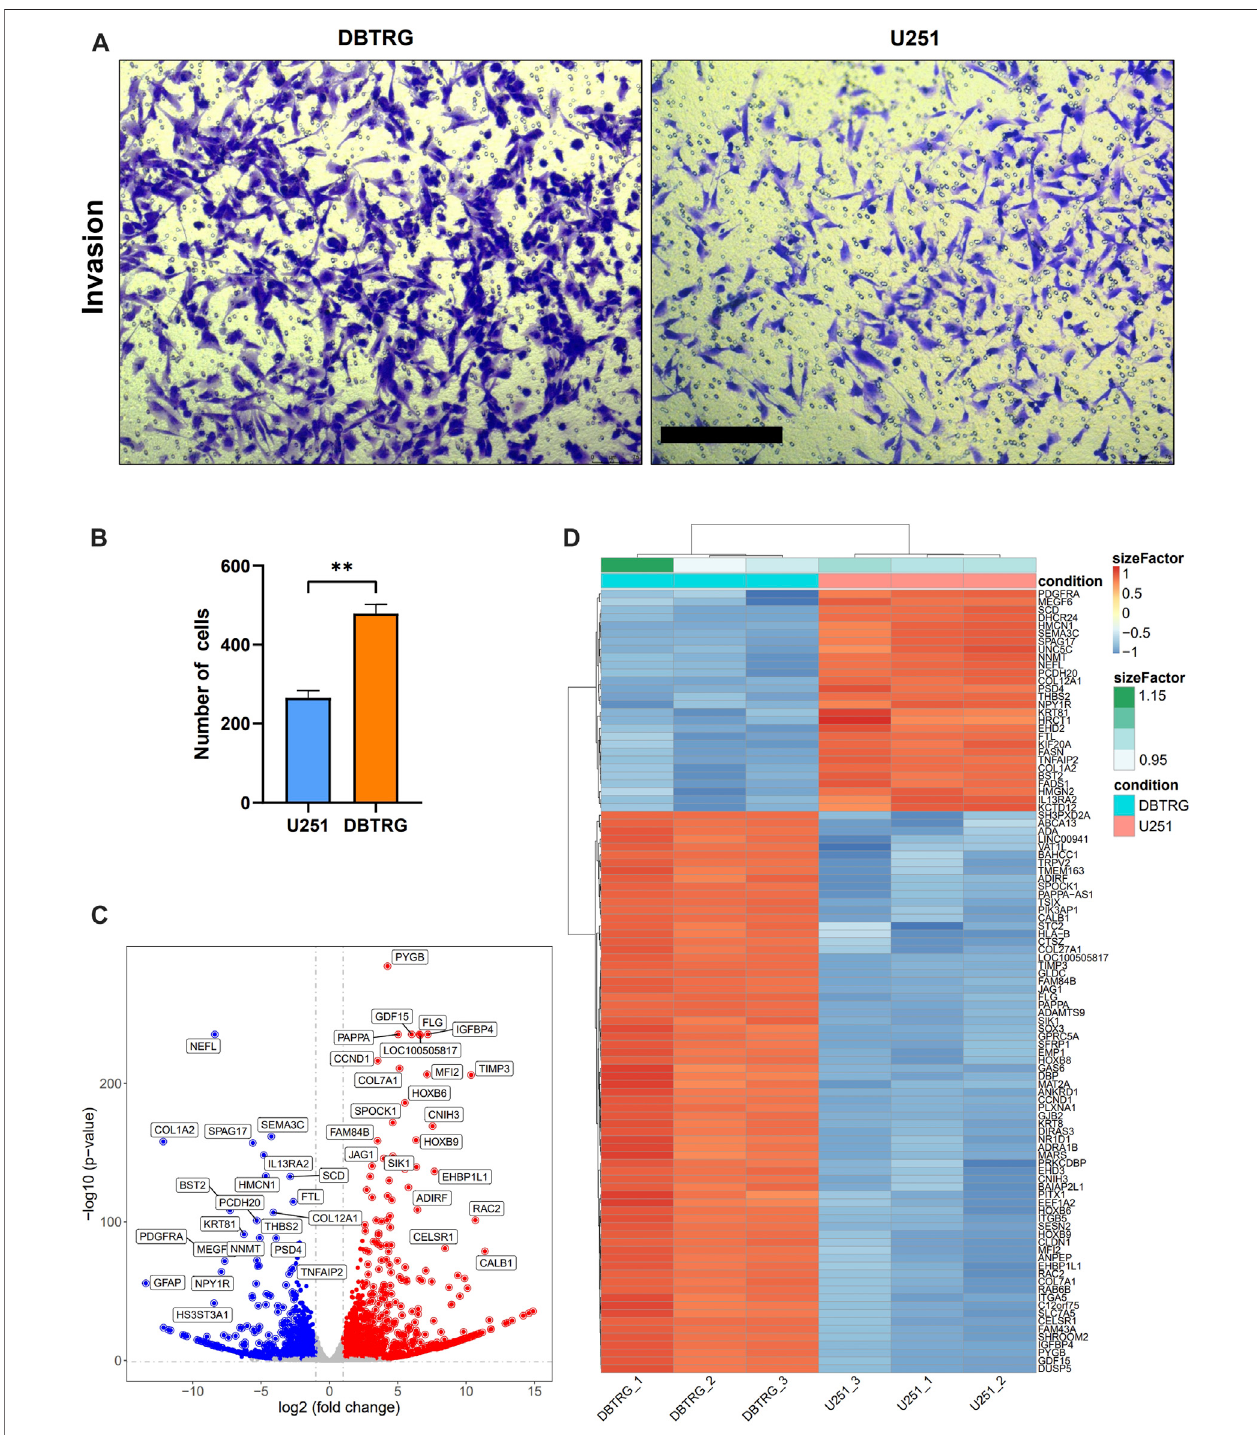
FIGURE 4 | Comparison of the invasion capacity and summary of DEGs between DBTRG and U251. (A) Representative images of the transwell invasion assay. Scale bar = 200 µm. (B) Statistical results of the transwell invasion assay. ** p < 0.01. (C) Volcano plot of the DEGs in DBTRG and U251 cells. (D) Heat map shows top DEGs in DBTRG and U251